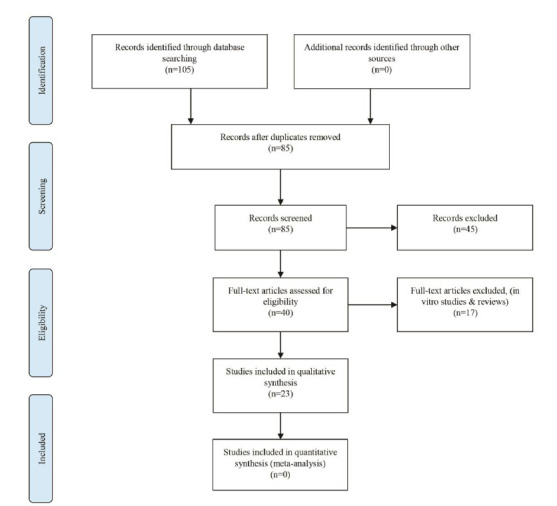
 Flow diagram describing the different phases of this systematic review